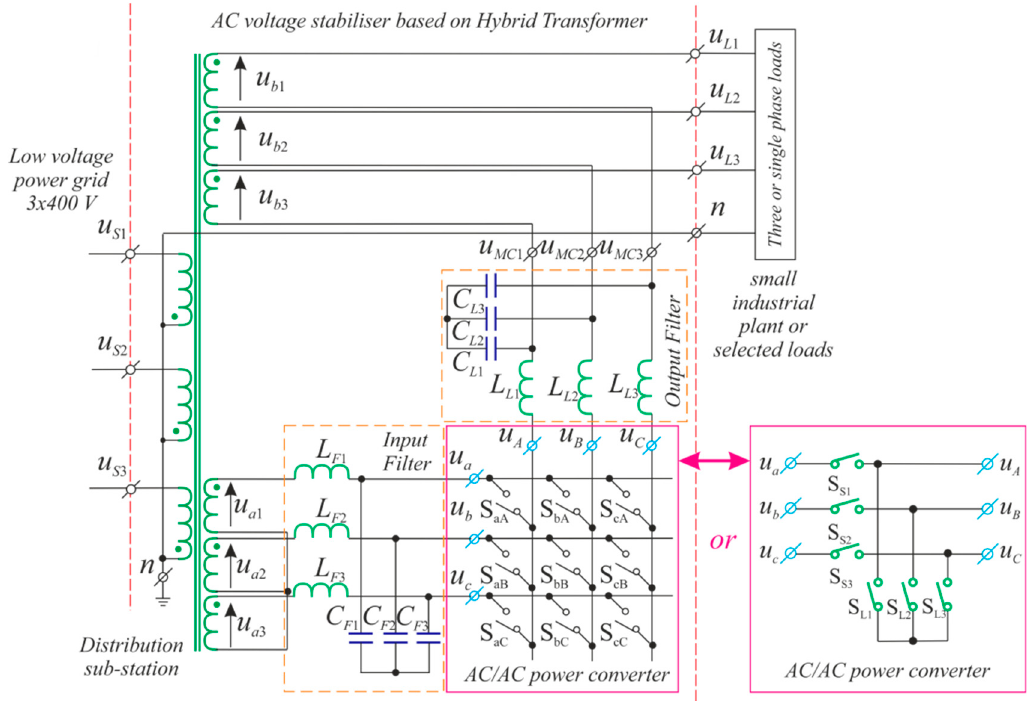
Figure 17. Compensator for voltage fluctuations, based on the HT with an MC or matrix chopper, installed at connection terminals of an industrial plant, a building, or selected industrial loads.